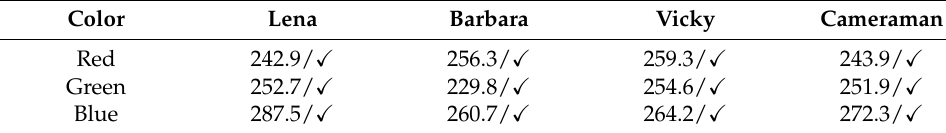
Table 12. Results of the Goodness-of-Fit test ( (cid:88) Accept, x Reject), with α =